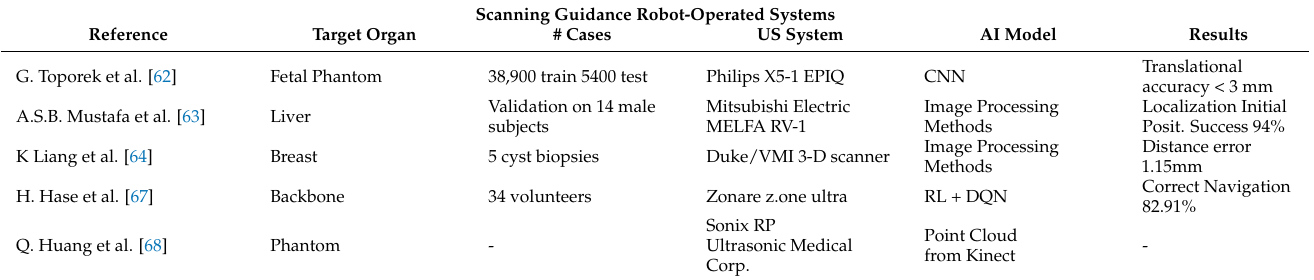
Table 4. Summary of publications on scanning guidance robot-operated